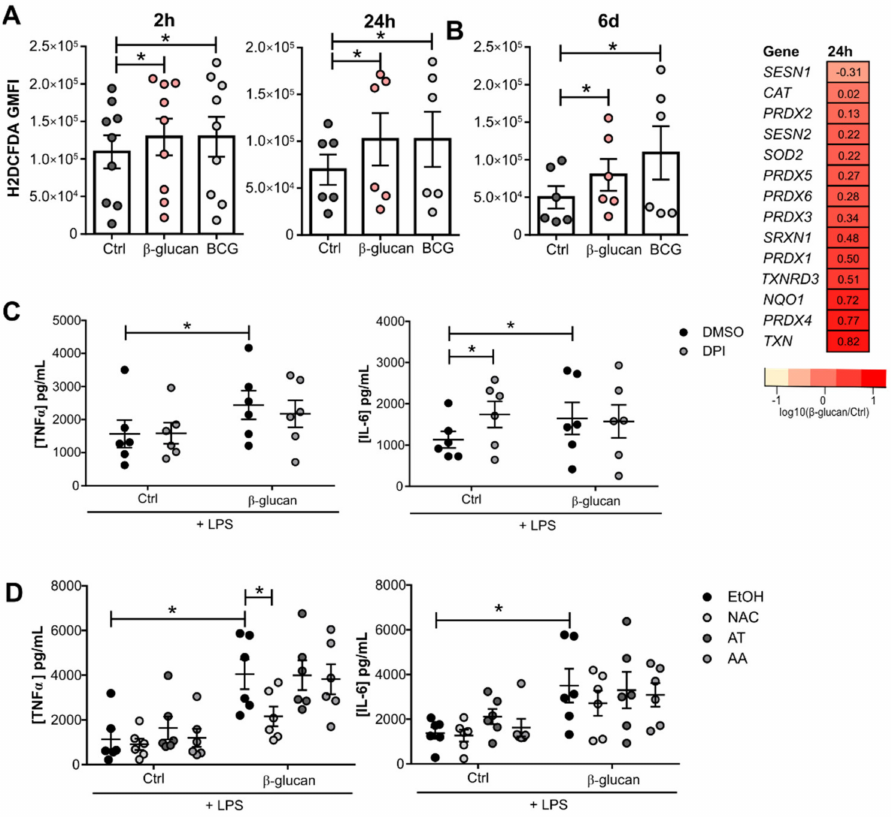
Figure 1. Increased ROS levels of trained monocytes do not contribute to their enhanced pro- inflammatory cytokine production. ( A ) ROS levels at 2 h, 24 h, and 6 days after exposure of monocytes to β -glucan and BCG ( n = 6/9 donors, pooled from 2/3 independent experiments. Fridman test Dunn’s multiple comparisons test). ( B ) Expression levels of genes involved in the antioxidant defense in monocytes exposed to β -glucan for 24 h in comparison to unstimulated cells. Expression presented as log 10 (ratio). TNF α and IL-6 produced by β -glucan-trained macrophages after a 1 h pretreatment with ( C ) 0.5 µ M DPI ( n = 6 donors, pooled from 2 independent experiments) and ( D ) 1 mM NAC, 50 µ M AT or 0.5 µ M AA ( n = 6 donors, pooled from two independent experiments, two-way ANOVA, Sidak’s multiple comparisons test). (mean ± SEM, * p <